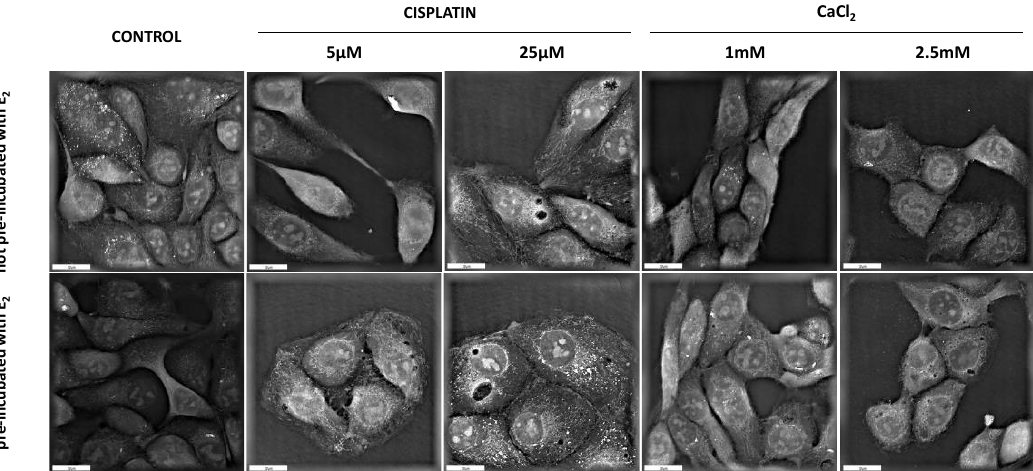
Figure 8. Holotomographic microscopy studies after 24 h with cisplatin and CaCl 2 . Scale bars represent 20 µM.